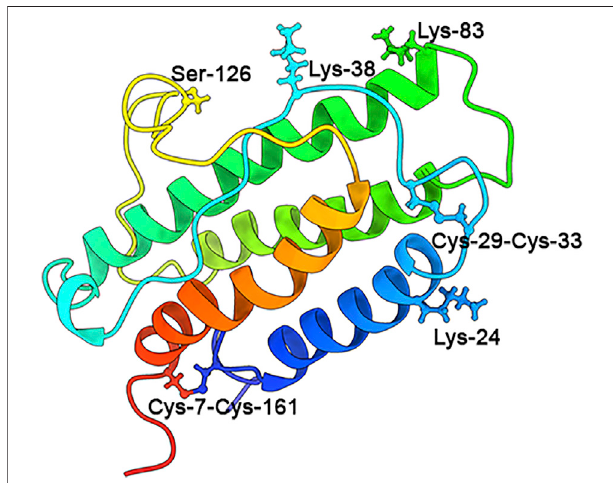
FIGURE 1 | Human EPO structure. The globular three-dimensional structure: four amphipathic α helices, two β -sheets, and two intra-chain disul fi de bridges (Cys-7-Cys-161 and Cys-29-Cys-33) (Bunn, 2013; Jelkmann, 2013; Sinclair, 2013; Ostrowski and Heinrich, 2018). The three N-linked polysaccharide groups are Lys-24, Lys-38, and Lys-83, and the one O-linked group is Ser-126 (PBD ID: EER).